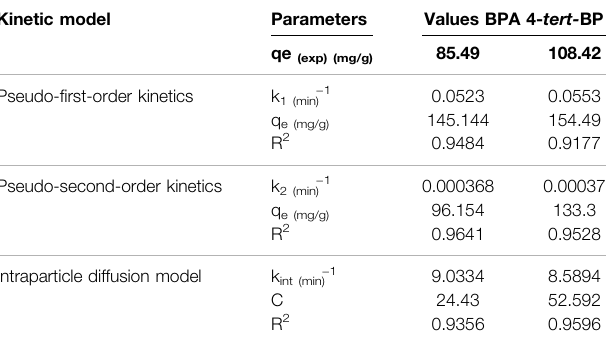
TABLE 1 | Kinetic parameters for BPA and 4- tert -BP adsorption onto MC adsorbent.